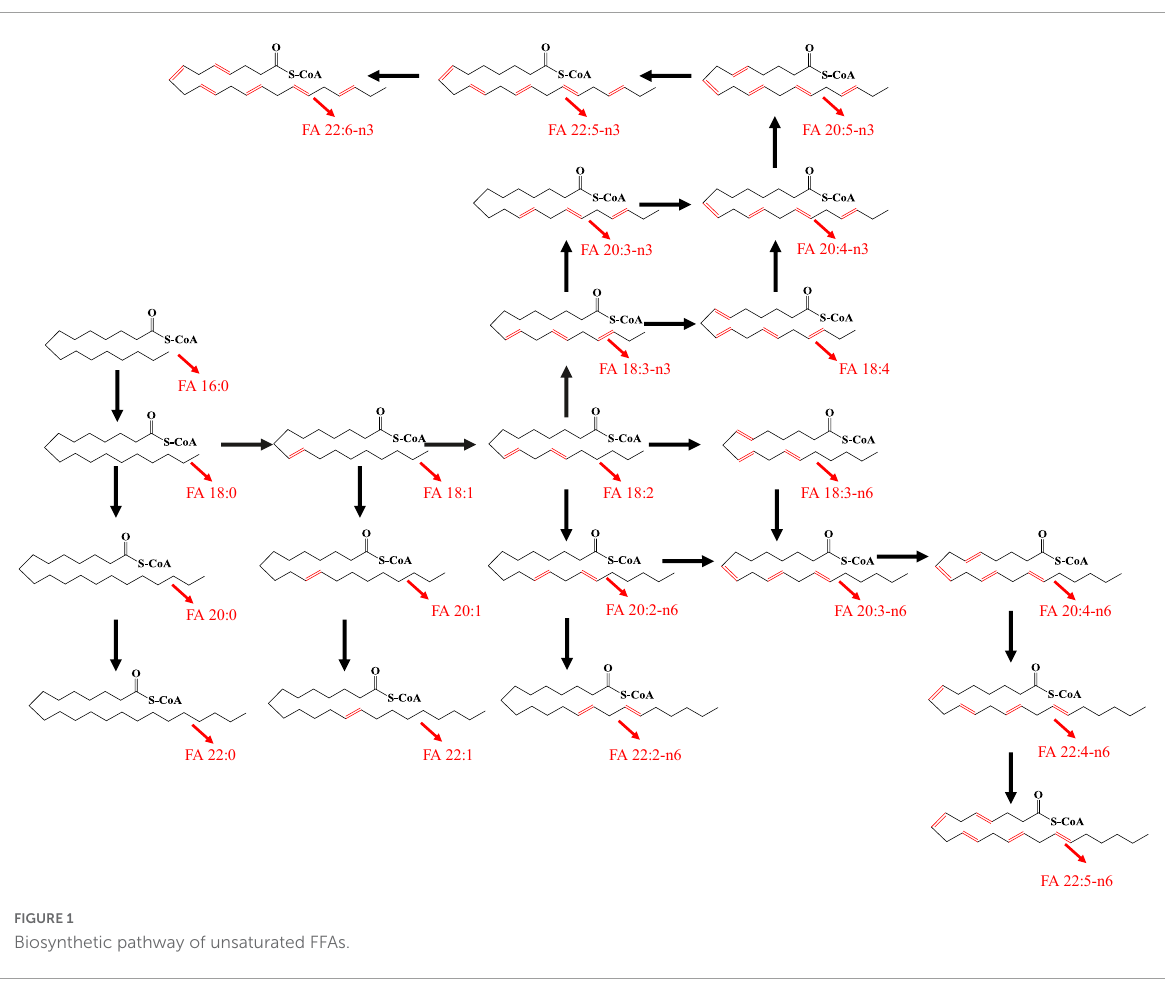
group than the T2DM group, except for MCHC, PA, PLT, HDL- C, LDL-C, IBIL, HbA1c, and TC. Indicators with FCs greater than 2 included CK, AST, FA 18:4, FA 22:5-n3, FA 20:3, FA 17:1, FA 16:1, FA 14:0, and FA